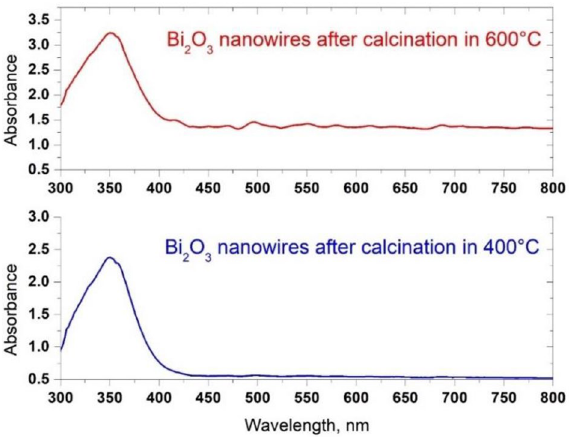
Figure 7. UV–Vis spectra recorded for the obtained one-dimensional bismuth oxide nanostructures produced by calcination of fibrous composite PAN/Bi 2 O 3 mats at 400 °C ( a ) and 600 °C ( b